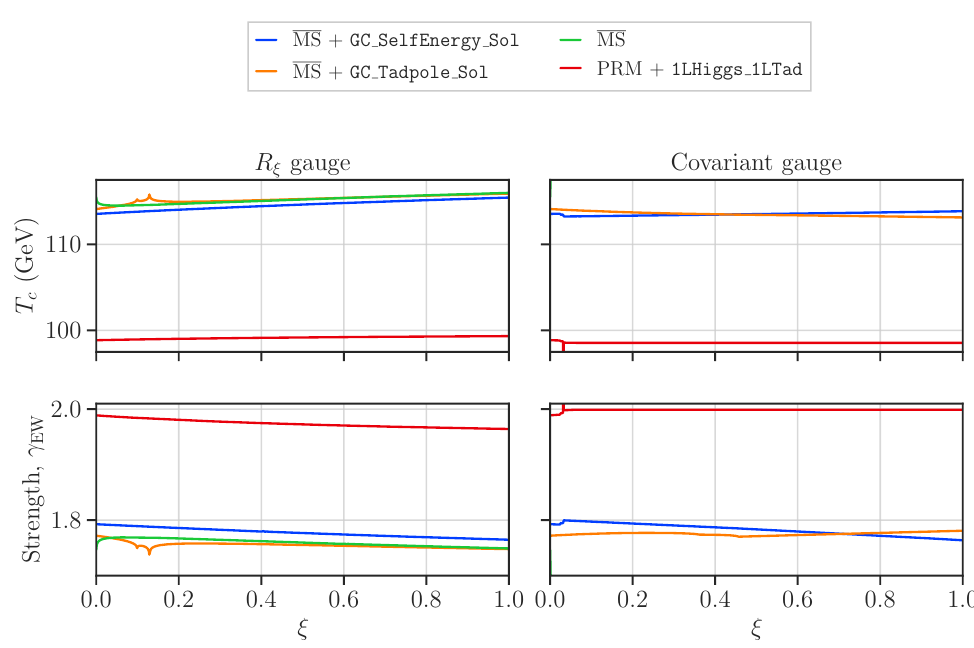
Figure 3 . As per figure 2, but for ξ ≤ 1 . Lines for PRM and HT are not shown here, as they are independent of ξ and exactly the same as in figure